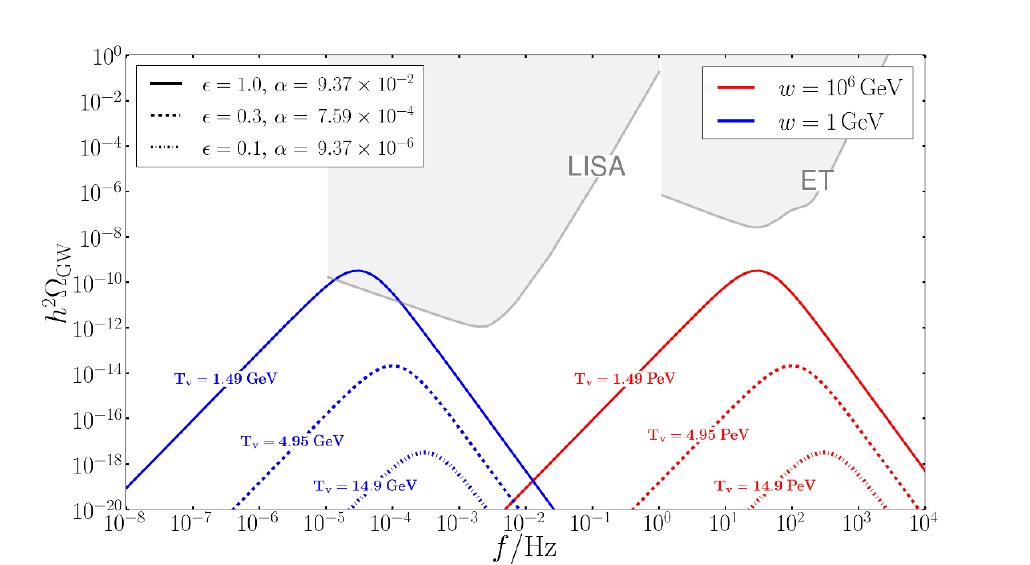
Figure 7 . Example gravitational wave spectra from thermal transitions in the model described in section 2. Results are shown for di(cid:11)erent hidden and visible sector temperature ratios (cid:15) , and scales w which determine the hidden sector temperature that the transition occurs at. We (cid:12)x g = 2, and adjust ~ m 2 such that (cid:11) h = 1 remains (cid:12)xed. As (cid:15) decreases, the thermal energy in the visible